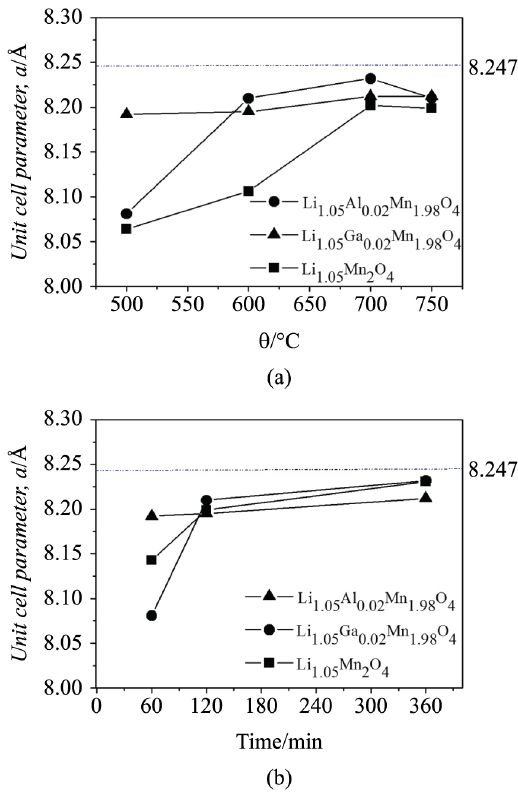
Figure 6. Unit cell parameters of the Li and Li Al Mn O (Å) as a function of the: (a) temperature 1.05 0.02 1.98 4 calcination (for 120 min); (b) time calcination (at 750 °C).